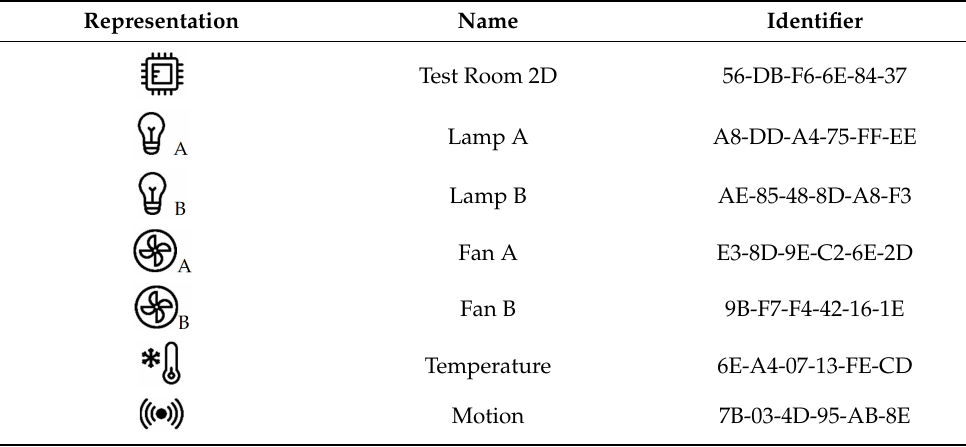
Table 4. Two-dimensional virtual environment devices. Lamp, fan, temperature, and motion detection profiles were used to set up this virtual